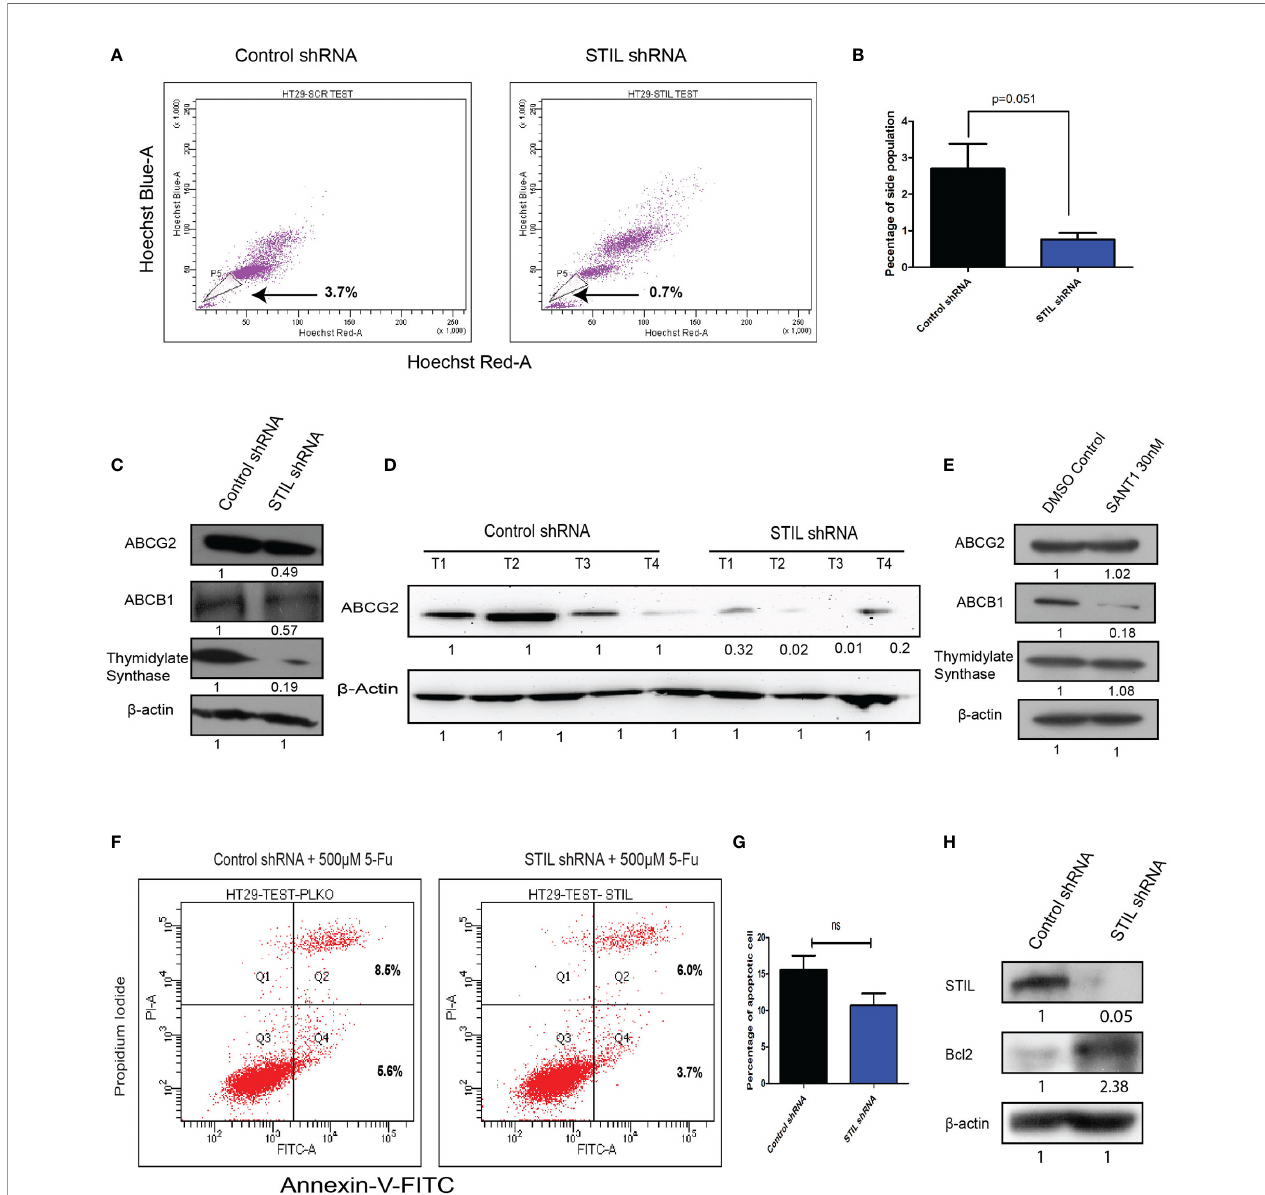
FIGURE 5 | Effect of STIL silencing on drug ef fl uxing cells and associated genes in CRC. (A, B) Dot plot showing side population cells and bar plot representing quanti fi cation of the same. (C) Western blot showing expression of ABCG2, ABCB1, and thymidylate synthase protein expression, upon STIL silencing. (D) Western blot showing ABCG2 protein expression in control and STIL -silenced tumor xenograft. (E) Western blot showing expression of ABCG2, ABCB1, and thymidylate synthase protein expression, upon SANT1 treatment. (F, G) Annexin-V assay showing percentage of cell death upon 5-FU treatment. (H) Western blot showing Bcl2 expression upon STIL silencing. Unpaired t-test results showing p value ≥ 0.05, is represented by ns, not signi fi